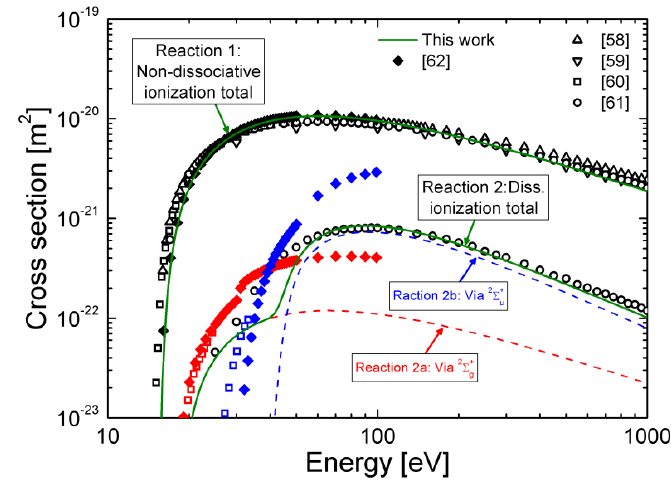
Figure 9. Non-dissociative and dissociative ionization cross-sections for the vibrational level v = 0 in the electronic ground state X 1 of the hydrogen molecule.